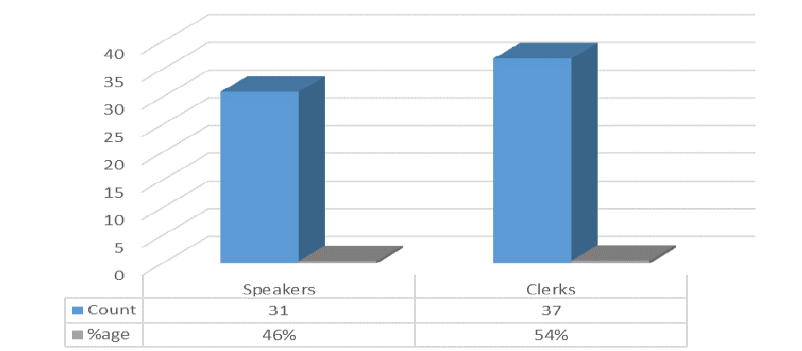
Fig. 3: County Assembly officials